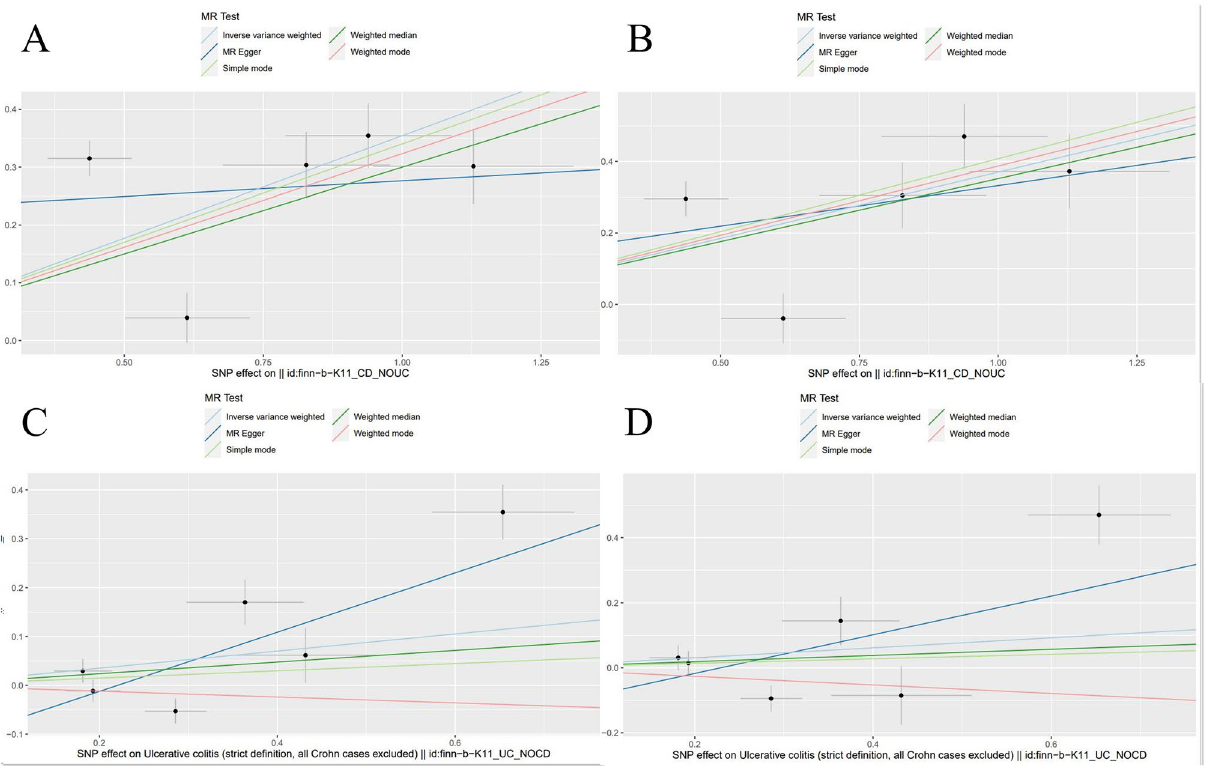
Figure 4. Scatter plots for MR analyses of the causal effect of CD and UC on psoriasis and PsA. ( A ) scatter plots for MR analyses of the causal effect of CD on psoriasis; ( B ) scatter plots for MR analyses of the causal effect of CD on PsA; ( C ) scatter plots for MR analyses of the causal effect of UC on psoriasis; ( D ) scatter plots for MR analyses of the causal effect of UC on PsA. MR Mendelian randomization, CD Crohn’s disease, UC ulcerative colitis, PsA psoriatic arthritis, SNP single nucleotide polymorphism.